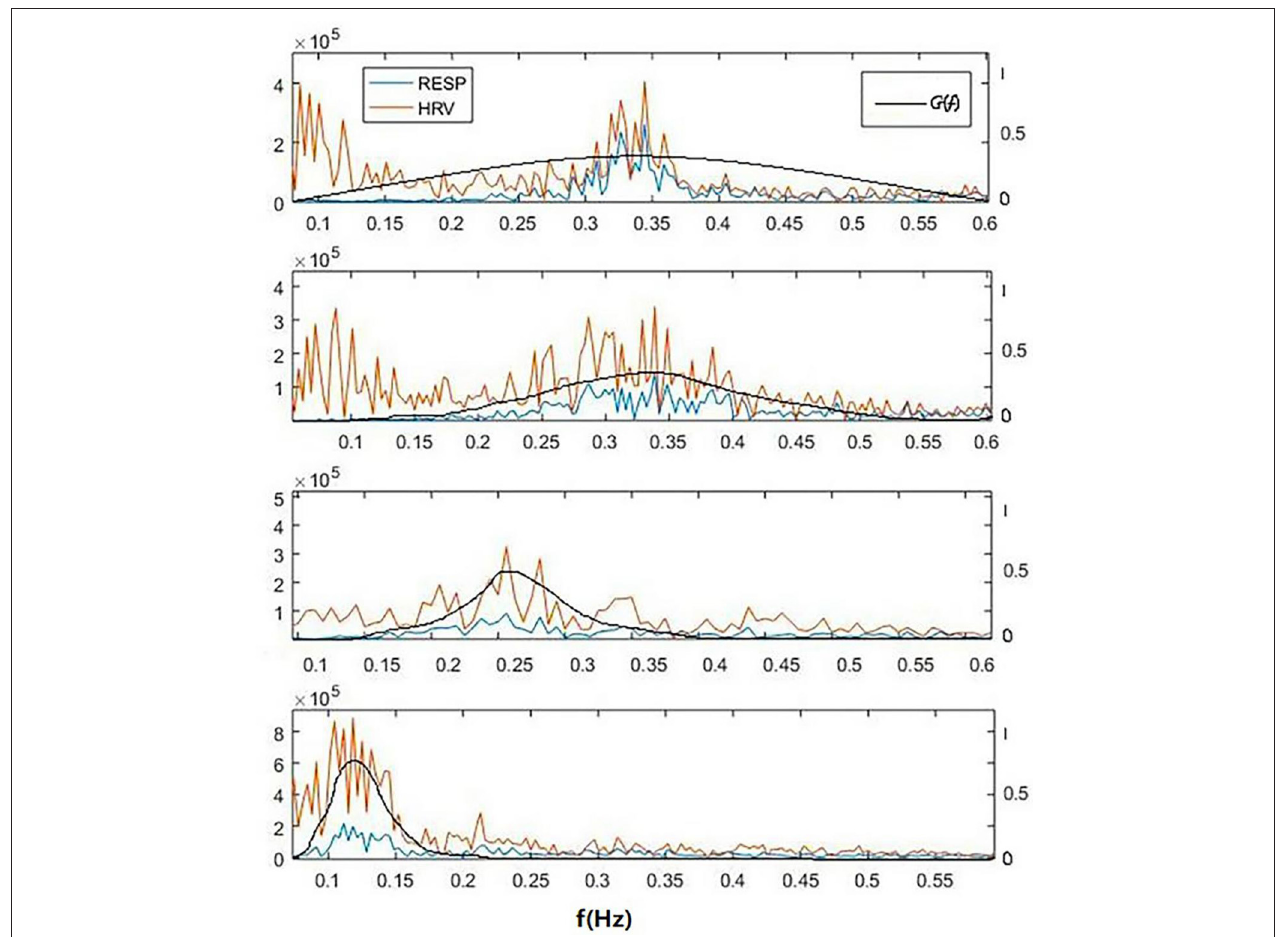
FIGURE 4 | A typical power spectral density curves of respiratory, HRV and corresponding cardiopulmonary resonance function CRF in the frequency domain of a subject for 4 cases of breathing at resting state. From the top: free breathing, paced breathing at frequency of 0.33, 0.26, and 0.12Hz. It can be seen that paced breathing increases the strength of RSA, and that as the frequency of paced breathing coming down toward, the cardiopulmonary resonance phenomenon becomes stronger, which is very well-captured by the cardiopulmonary resonance function. It can also seen that as the paced breathing frequency approaches 0.1Hz, around which there is an optimal resonance state for the subject, where HRV_HF is small. That is to say that CRI do represent level of parasympathetic nervus activity at various cases, while HRV do not.